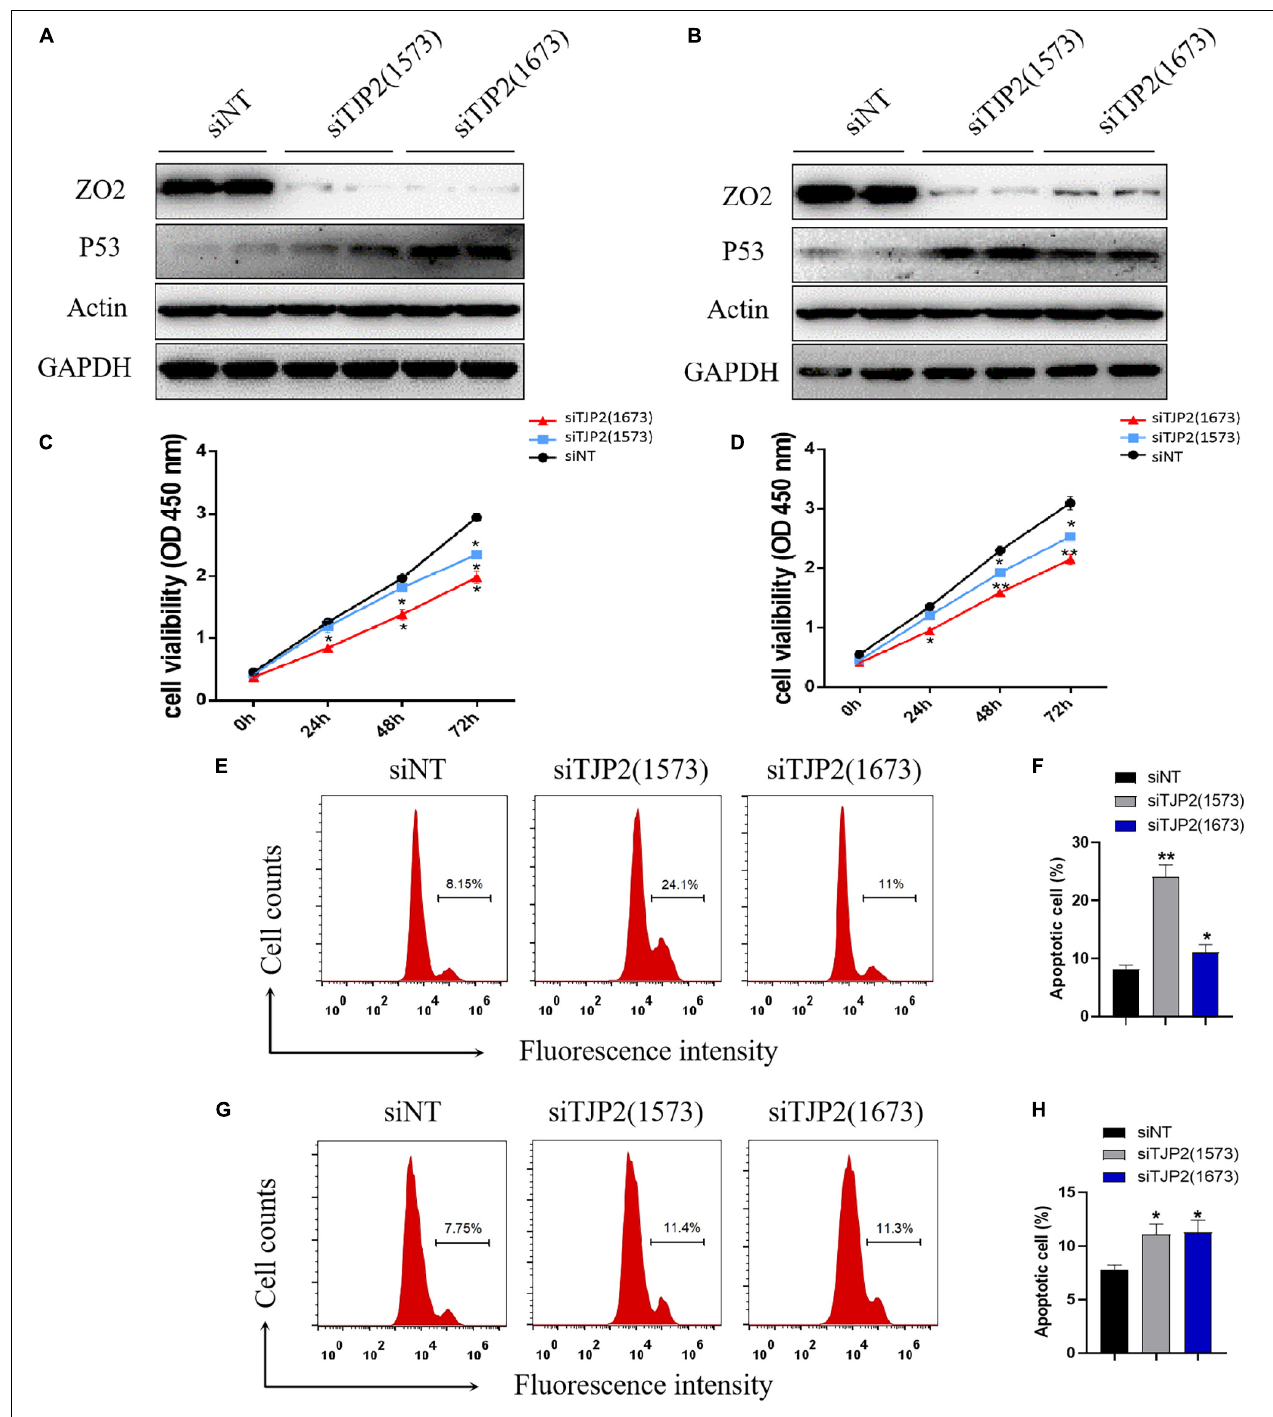
FIGURE 3 | TJP2 protein deficiency leads to an increase in TP53 protein expression, inhibition of cell proliferation and induction of apoptosis in LO2 and HepG2 cells. (A) Downregulation of the TJP2 gene by two siRNAs (1573 and 1673) remarkably decreased the TJP2 protein expression and increased TP53 protein expression in LO2 cells in comparison with negative control (siNT). (B) Downregulation of TJP2 protein by two siRNAs (1573 and 1673) dramatically decreased the TJP2 protein expression and increased TP53 protein expression in HepG2 cells in comparison with negative controls. (C) Knockdown of TJP2 protein by siRNAs caused a significant decrease in cell proliferation in LO2 cells at 48 h and 72 h after transfection of siRNAs. (D) Knockdown of TJP2 protein by siRNAs caused a significant decrease in cell proliferation in HepG2 cells at 48 h and 72 h after transfection of siRNAs. (E,F) Silencing TJP2 protein expression by siRNAs induced cell apoptosis in LO2 cells. (G,H) Silencing TJP2 protein expression by siRNAs induced cell apoptosis in HepG2 cells. The data is presented as mean ± standard deviation ( n = 3, * p < 0.05, ** p < 0.01). ZO2, 150 kDa; P53, 53 kDa; ACTIN, 42 kDa; GAPDH, 37 kDa.